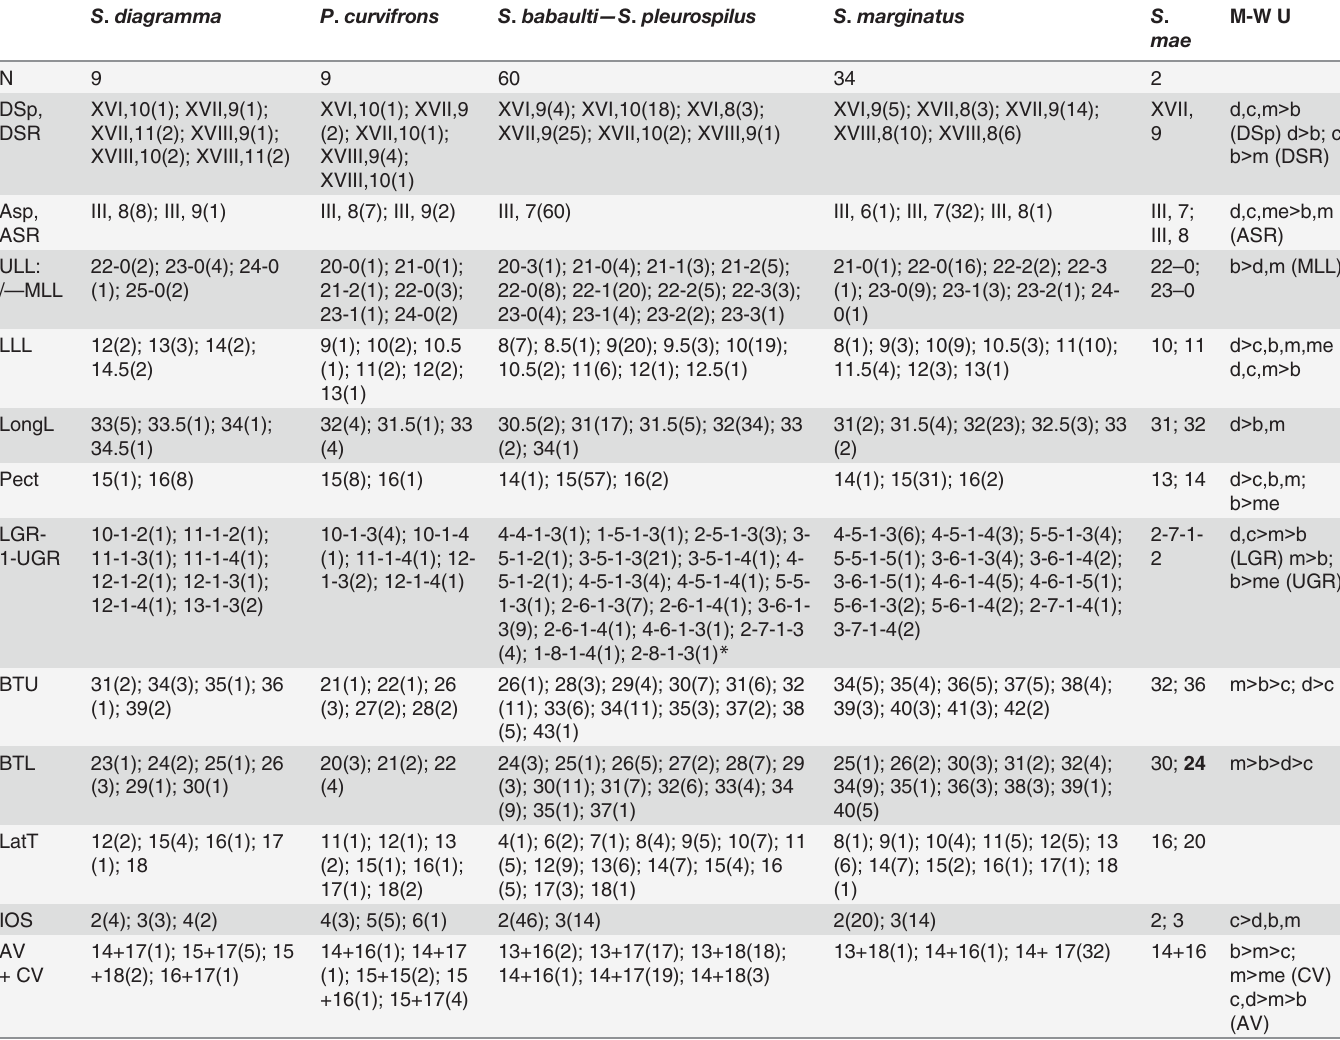
Values for S . pleurospilus and S . babaulti are grouped together. Mann-Whitney U tests are summarised with d: S . diagramma , c: P . curvifrons , b: S . babaulti and S . pleurospilus , m: S . marginatus and me: S . margaretae ( S . mae ). ULL is the sum of the two values, reduced and non-reduced gill rakers are listed separately for S . babaulti , S . pleurospilus , S . marginatus and S . margaretae